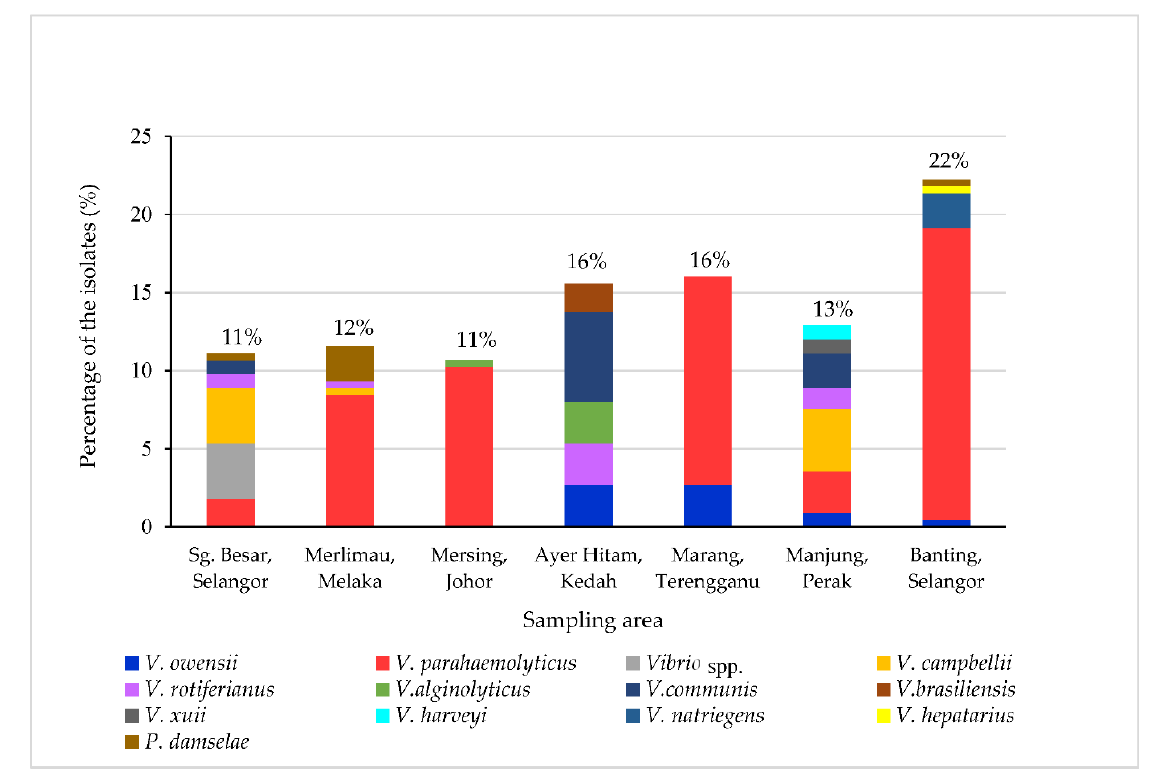
Figure 2. The prevalence of Vibrio spp. from seven farms in Peninsular Malaysia.